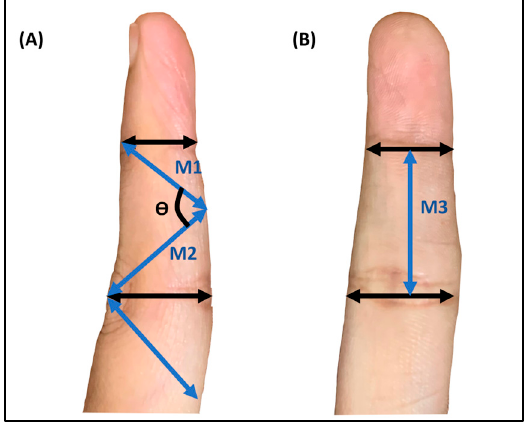
Figure 2. Dimensions recorded in the fingers ( A ) Lateral view showing circumferential and oblique measurements, ( B ) Palmar view showing linear measurements.